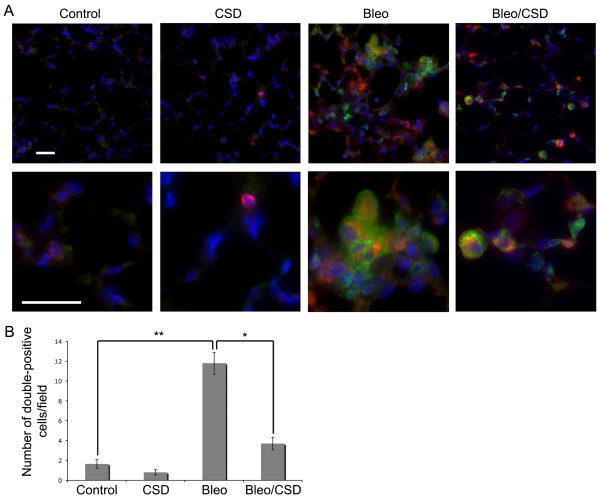
CSD peptide inhibits the bleomycin-induced accumulation of CD45+/ColI+ fibrocytes in lung tissue. Sections from saline-treated mice receiving the CSD peptide (CSD) or the control, scrambled peptide (Control) and sections from bleomycin-treated mice receiving the CSD peptide (Bleo/CSD) or the scrambled peptide (Bleo) were harvested ten days after treatment, then stained for CD45 (green) and ColI (red). Nuclei were labeled with DAPI (blue). (A) Upper row: merged low-magnification images. Lower row: merged high-magnification images. Bars = 10 μm. (B) The average number of CD45+/ColI+ fibrocytes per field was determined in images from six mice in each category, with five fields per mouse. **P < 0.01. *P < 0.05.